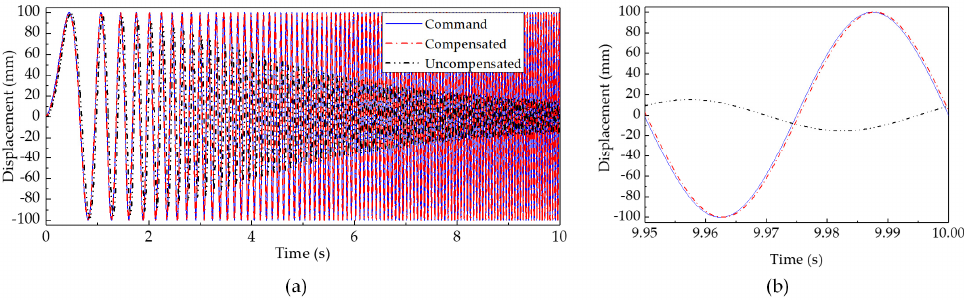
Figure 4. Tracking performance of the second-order transfer function. ( a ) Overview; ( b ) Enlarged